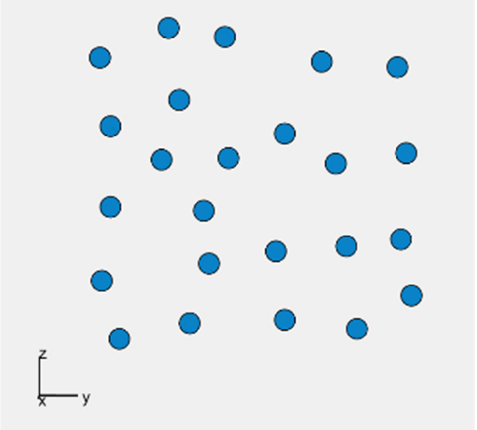
Figure 8. The optimal panel with 24 microphones obtained using the GA_square algorithm in coordinate system, x being the broadside direction.